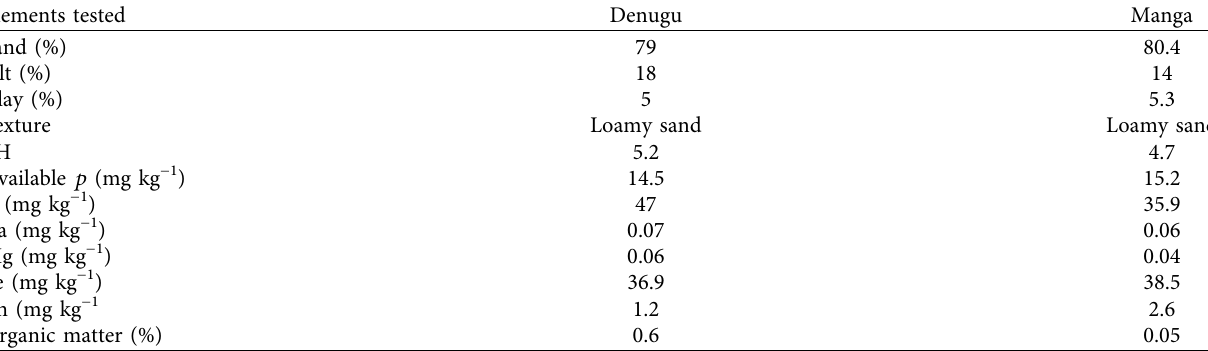
Table 3: Soil physiochemical properties of experimental fields at a depth of 0–30cm before establishment of trials at Manga and Denugu